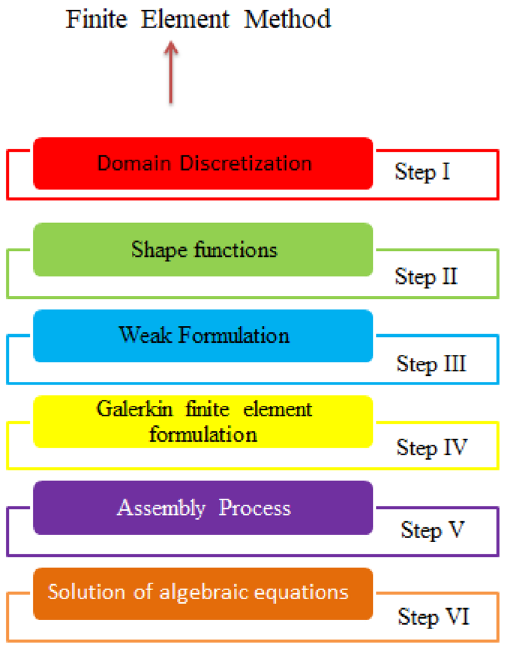
Figure 2. FEM related